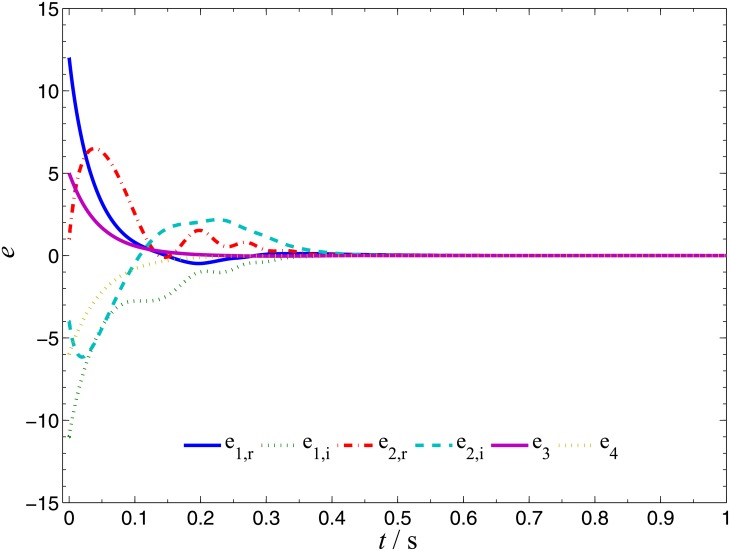
CGS errors of systems (12) and (13).